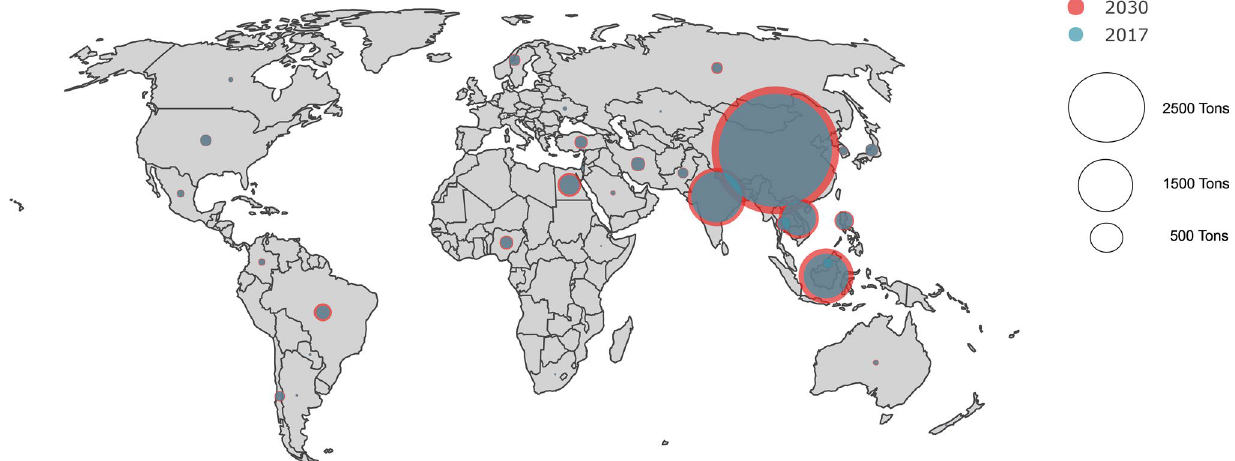
Figure 1. Antimicrobial consumption in aquaculture in 2017 and 2030 (projected, Supplementary